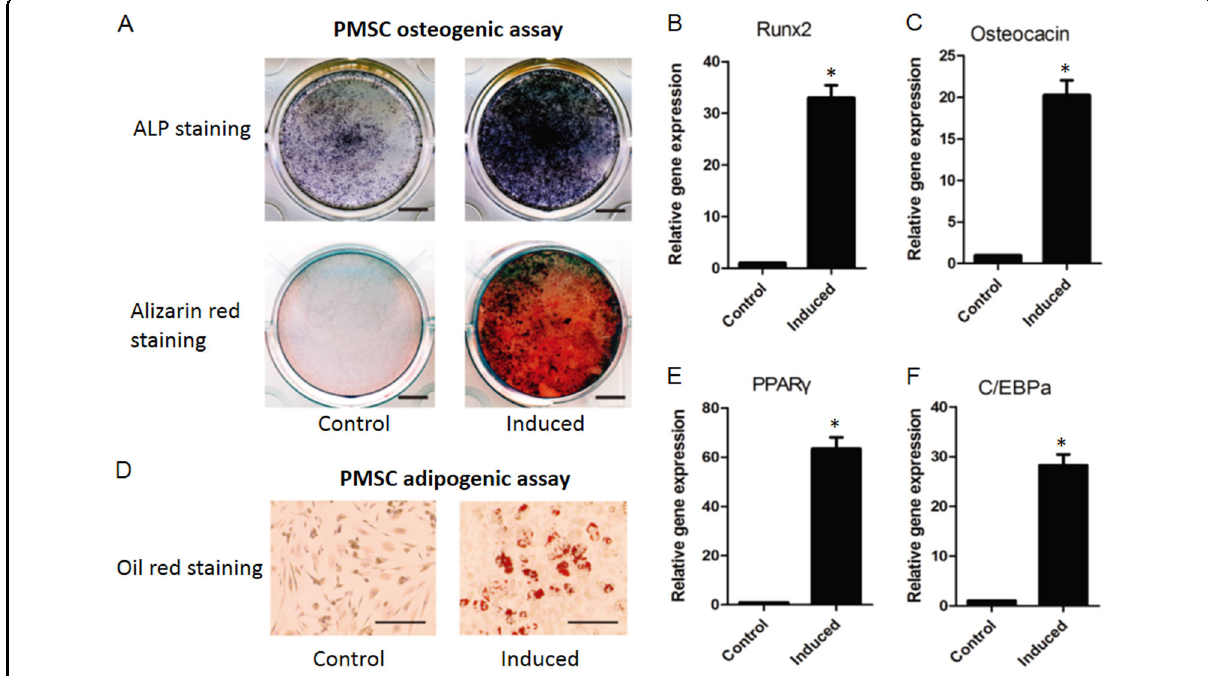
Fig. 2 Analysis of PMSC osteogenic and adipogenic differentiation. a Osteogenic differentiation was examined by alkaline phosphatase staining and alizarin red staining without (Control) induction or with induction (Induced). Bar indicates 100 µm. b , c Osteogenic differentiation markers Runx2 and osteocalcin were further examined by real-time PCR. d Adipogenic differentiation was studied by the detection of lipid vacuoles by oil red O staining with or without induction. Bar indicates 50 µm. e , f Adipogenic differentiation markers PPARr and C/EBPa were inspected by real-time PCR. The data are the means ± SD of three independent experiments and all the results were normalized to the internal control (* p < 0.05 compared with control PMSCs without